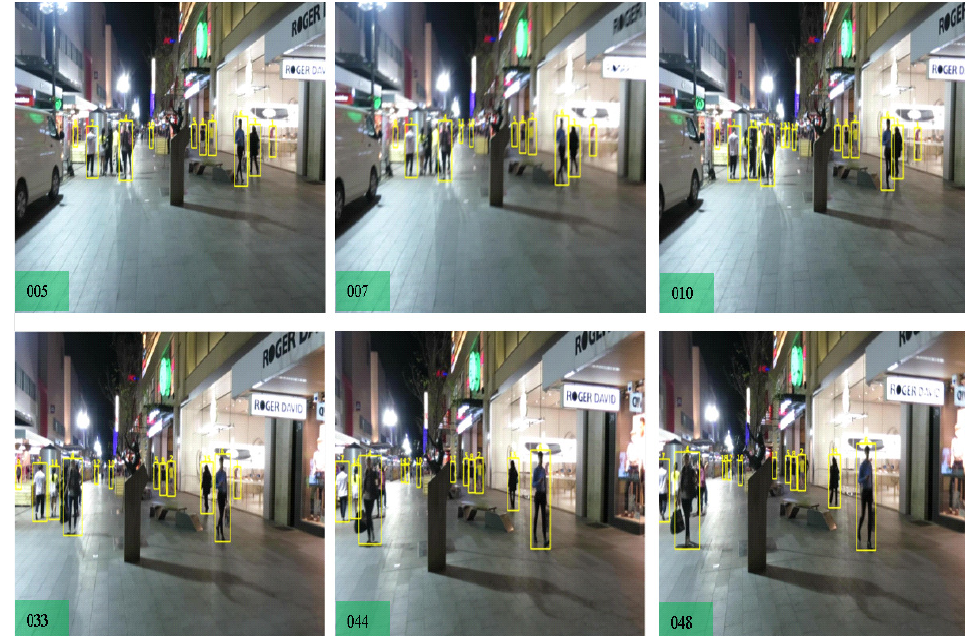
Figure 7. Effectiveness of our tracker in the case of moving camera. Our tracker is effectively tracking the multi-objects without becoming drifted on anchors by camera motion with the small objects inside the scene. The detected bounding box and the unique ID are demonstrated in yellow